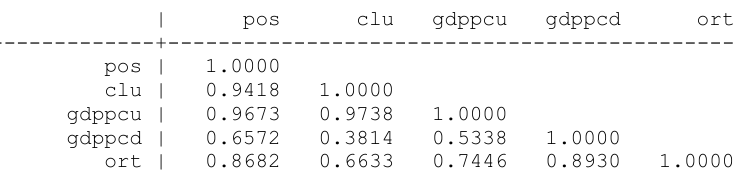
. corr pos clu gdppcu gdppcd ort